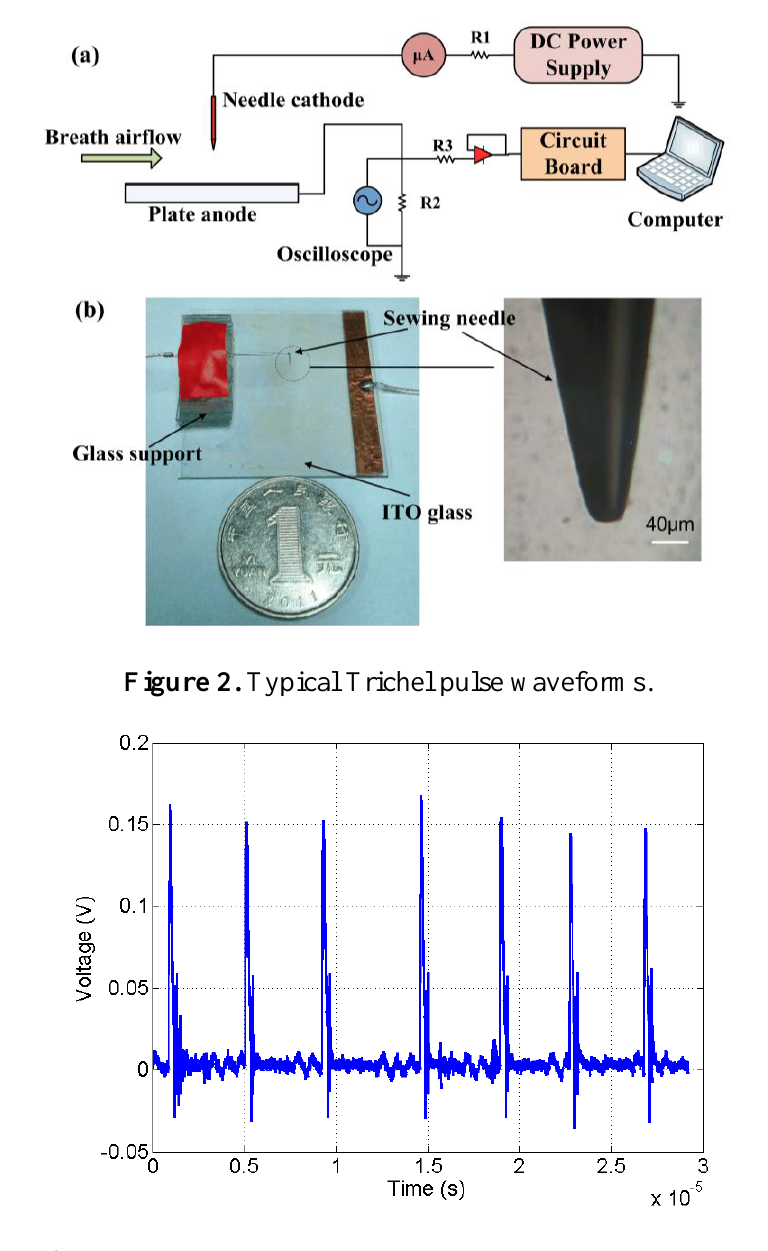
platform; ( b ) The practical needle-to-plate configuration and the morphology of needle tip.